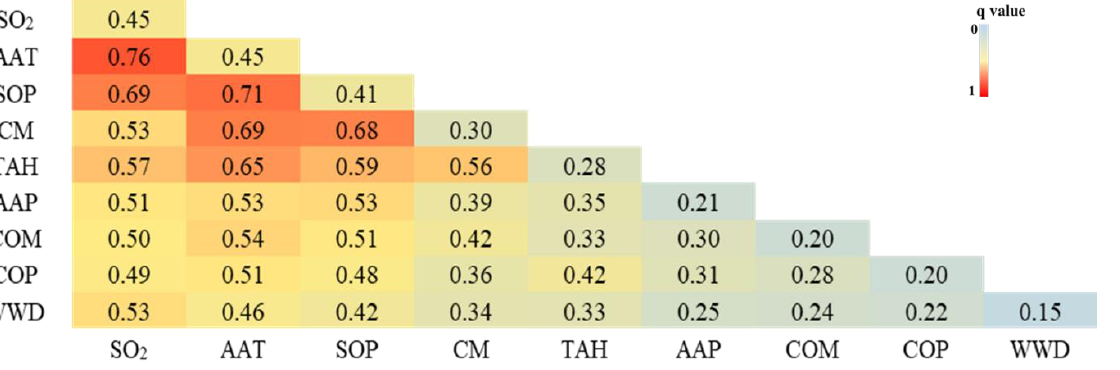
Table 6. Favorable conditions for the spread of Brucellosis.